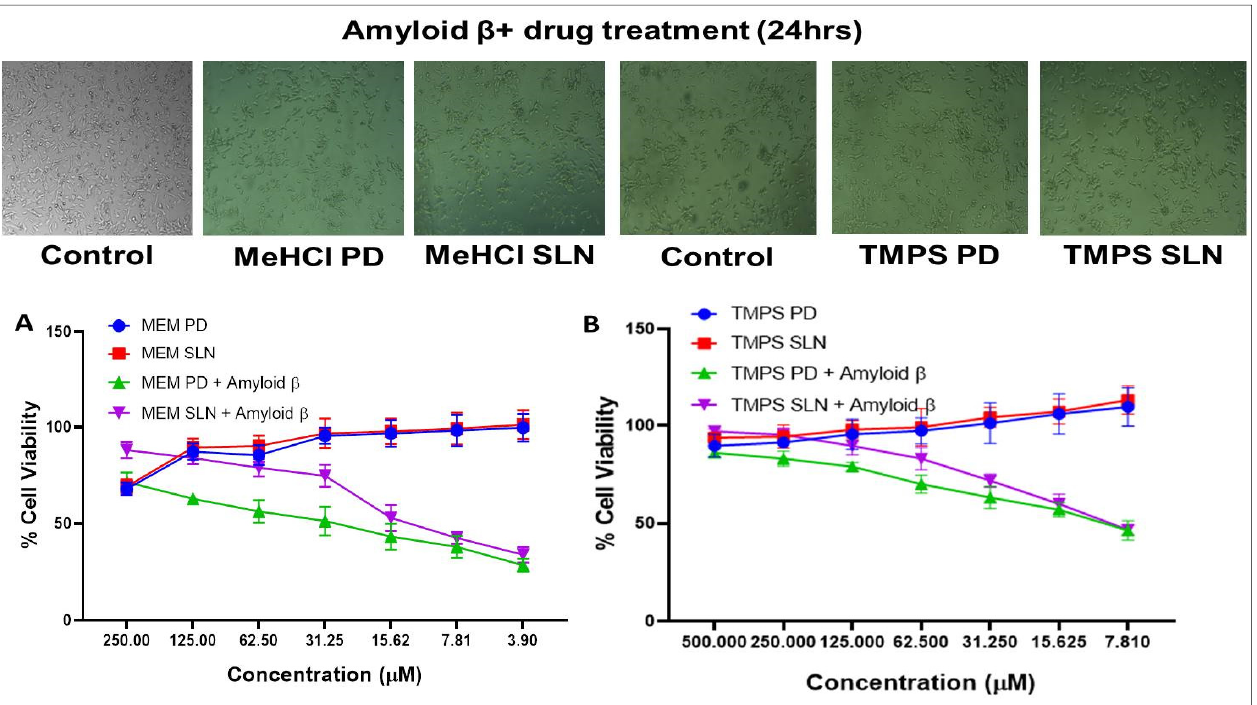
Figure 4. The % of Cell viability assay. ( A ) The dose dependent response of SHSY5Y cells on the treatment of MeHCl ( B ) The dose dependent response of SHSY5Y cells on the treatment of TMPS. Data is represented in mean ± SD ( n = 3).